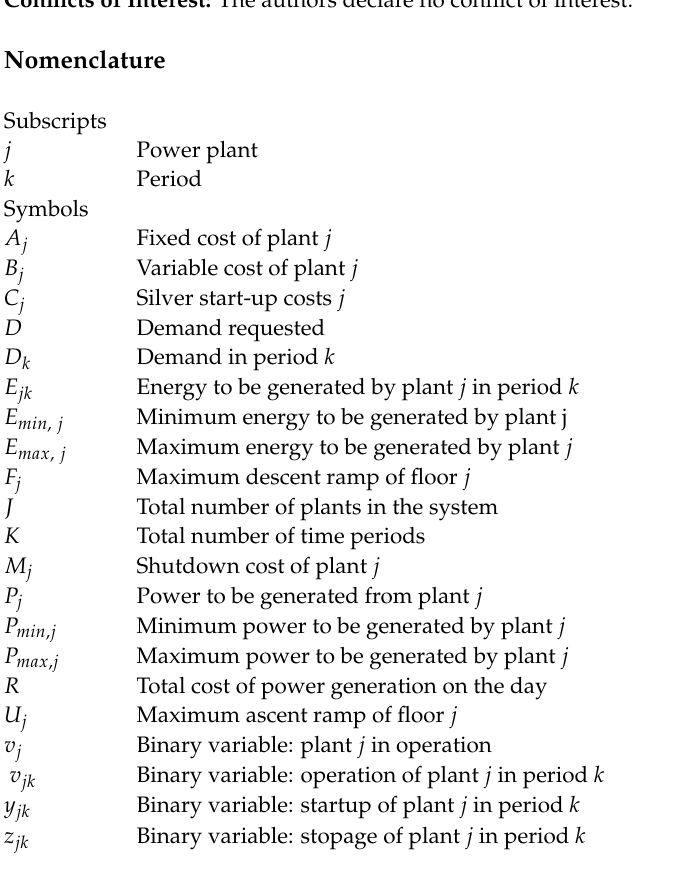
system. Table S2. Output values of the wind fuzzy system. Table S3. Input values to the hydraulic diffuse system. Table S4. Output values of the hydraulic diffuse system. Table S5. Input parameters of the linear system. Table S6. Results of electricity generation and total cost by plant for a winter day (January 15). Table S7. Results of electricity generation and total cost by plant for a